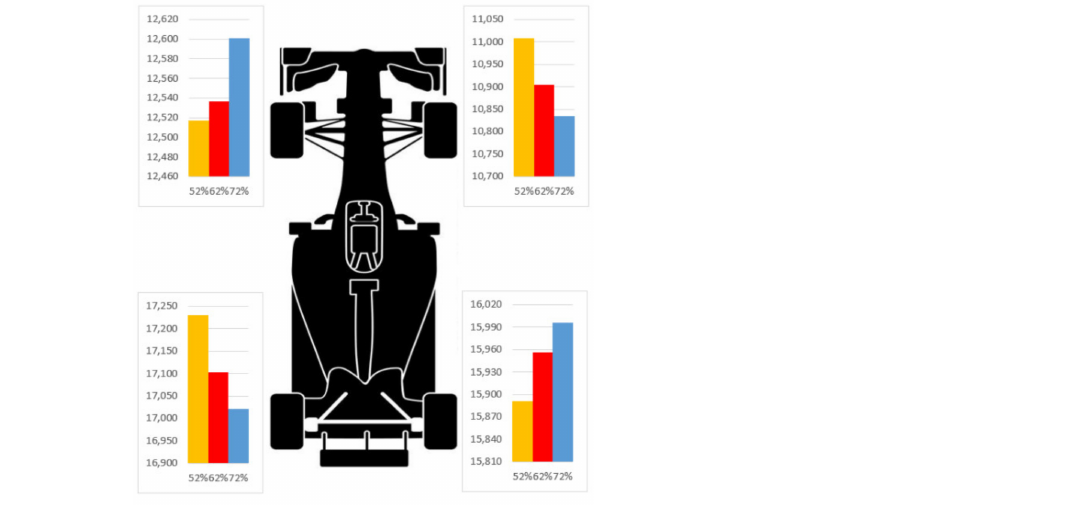
Figure 10. Sensitivity to roll stiffness distribution (% front) on Nürburgring GP. Energy is reported in kJ.